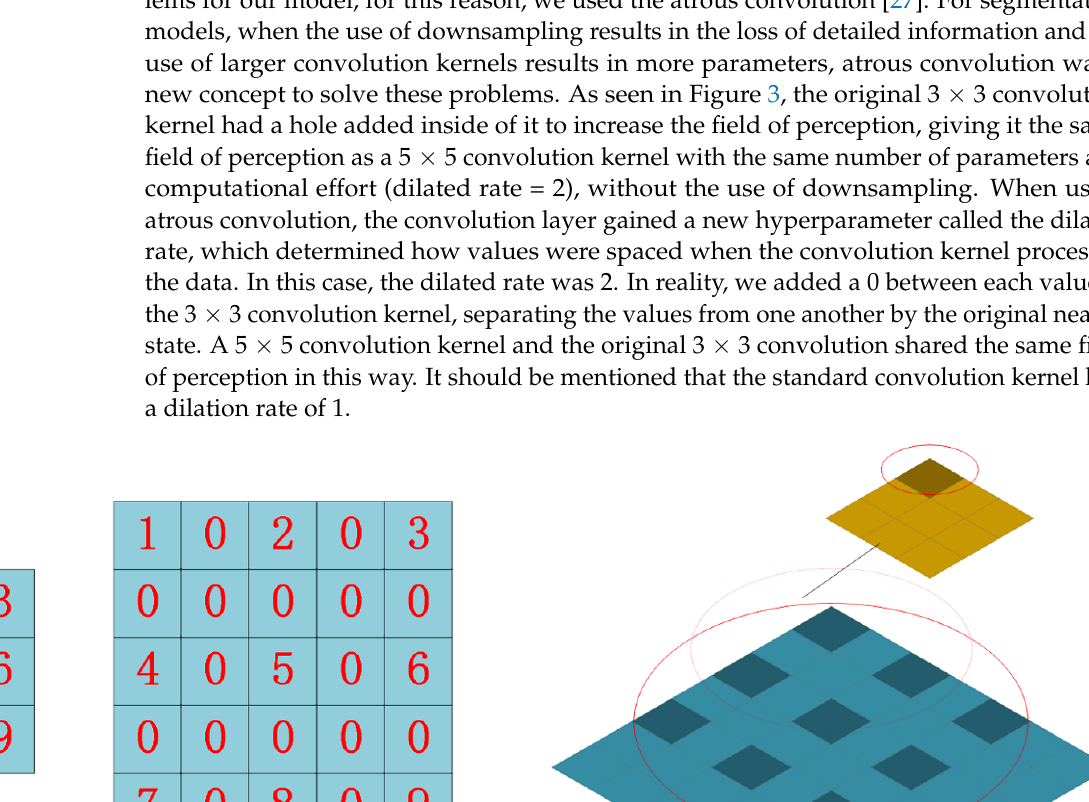
Figure 2. Different size convolutions correspond to different perceptual fields.